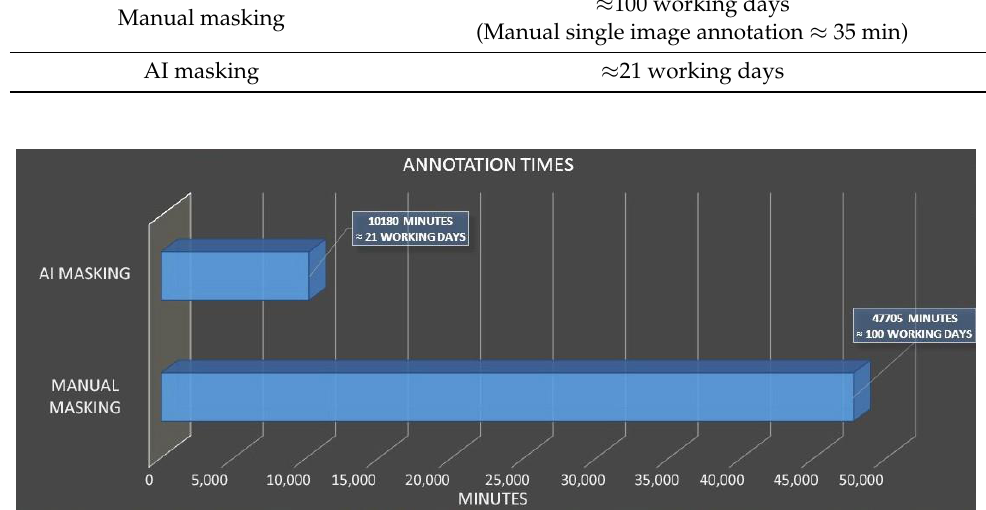
Figure 31. Merging of the two total dense clouds from the TLS and RPAS survey.